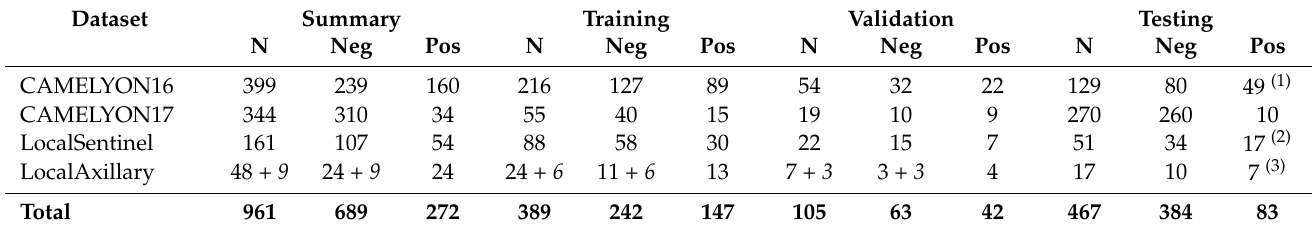
Table 3. Distribution of WSI for training, validation, and test of four of the datasets. Italicized numbers indicate added slides with extra-nodal tissue containing features of fat necrosis and foreign body tissue